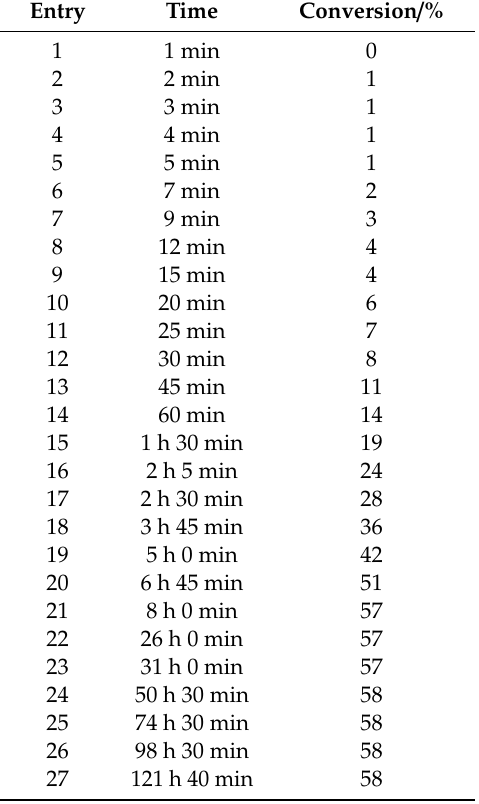
Table A4. Reduction of acetophenone ( 1 ) to 1-phenylethanol ( R )- 2 . Change from standard procedure: toluene